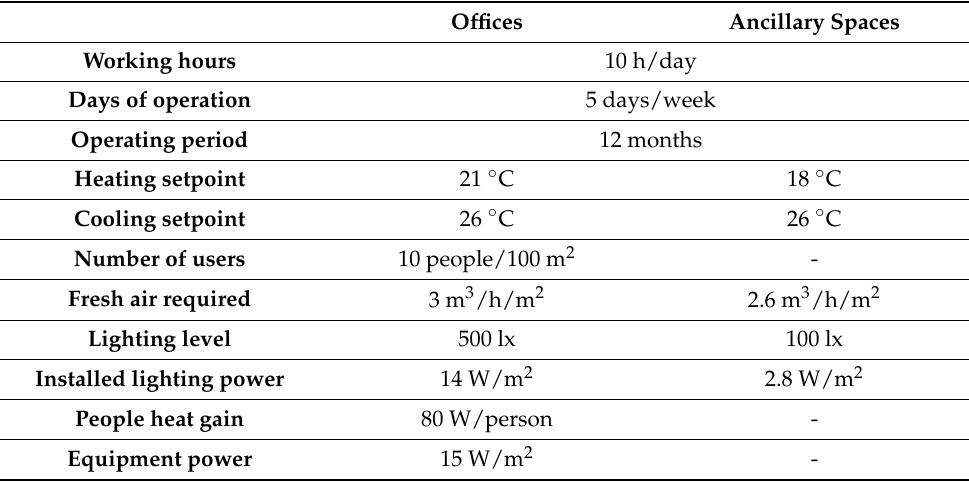
Table 3. Internal operating conditions of thermal